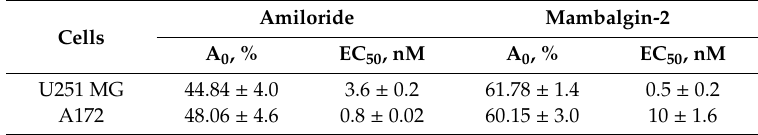
Table 1. Parameters descripting the mambalgin-2 effect on U251 MG and A172 cells proliferation. Amiloride Cells